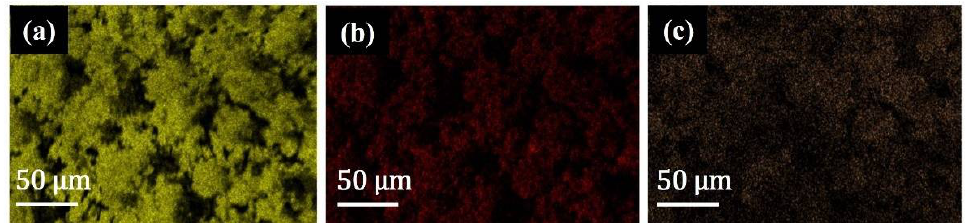
Figure 5. The elemental distribution of ( a ) silver; ( b ) oxygen; and ( c ) gold in the silver oxide electrode.